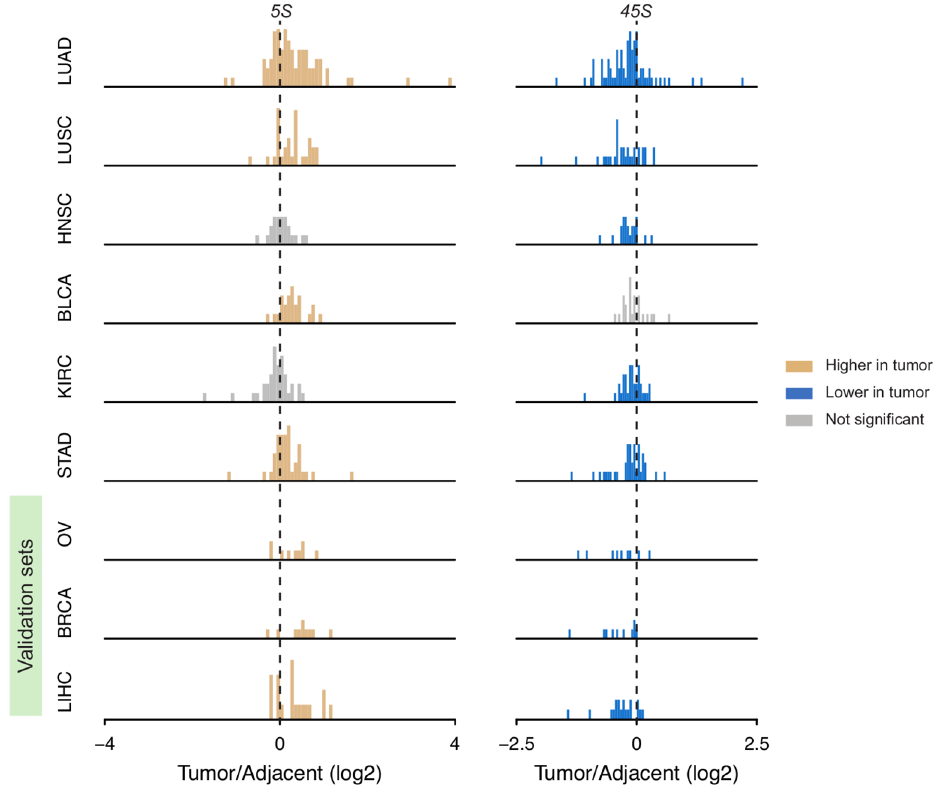
Fig 3. rDNA CN amplification and loss between cancer tissue and paired adjacent normal tissue. Yellowand blue denote significantgain or loss in tumors comparedwith pairedadjacent controls (one-sided pairedWilcoxon rank sum test P < 0.05 for OV and < 0.01 for others). There are 74, 32, 22, 24, 35, 38, 9, 10 and 19 informative patients for LUAD, LUSC, HNSC, BLCA, KIRC, STAD, OV, BRCA and LIHC respectively. OV, BRCA and LIHC were used as